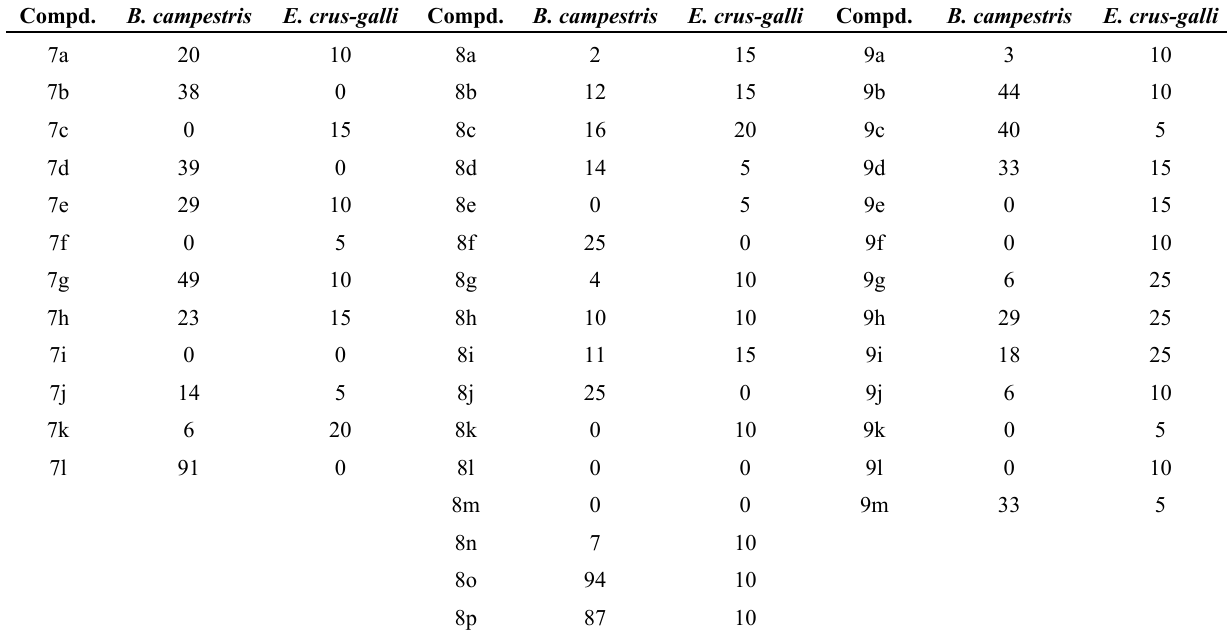
Table 1. The herbicidal activities (inhibition rate, %) of compounds 7 , 8 and 9 .